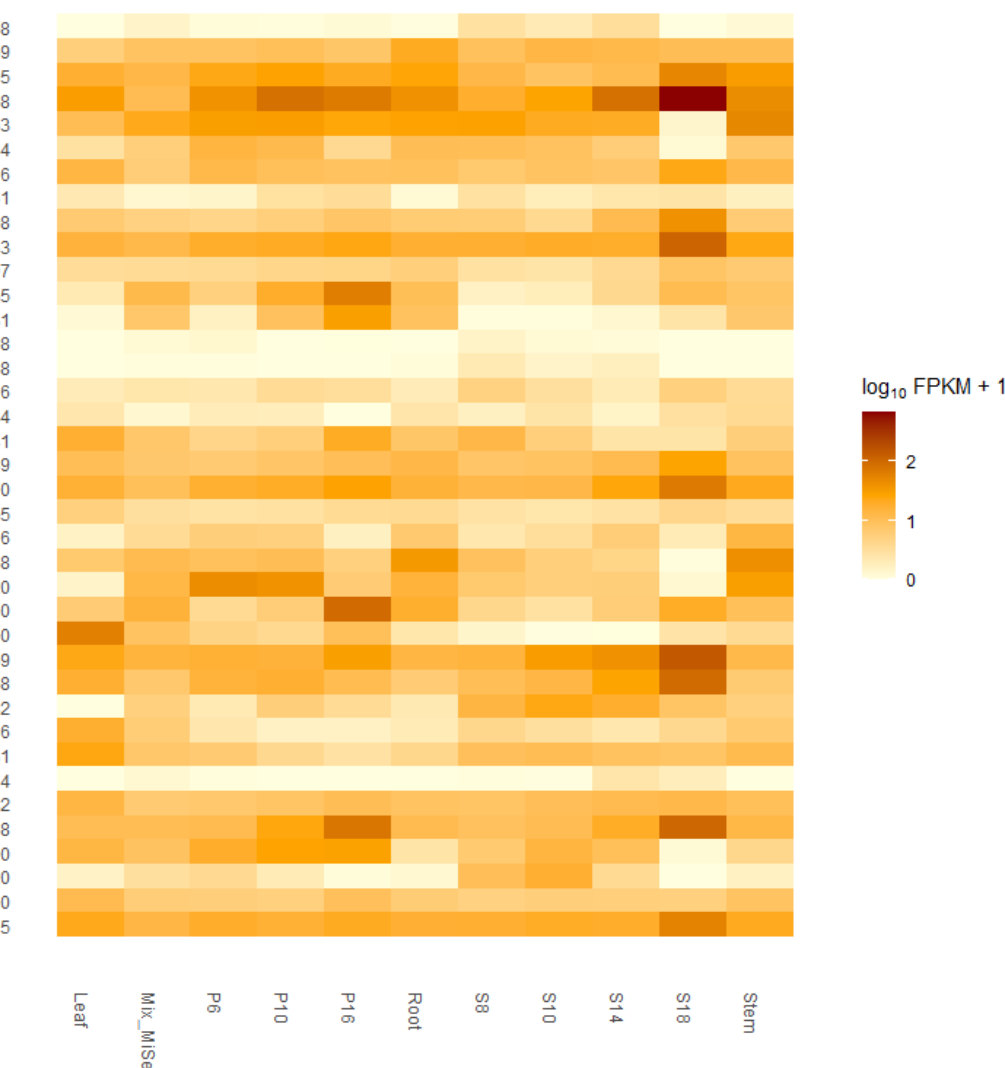
Figure 7. Expression of cowpea trihelix genes of major plant tissues at different developmental stages. (S8: Seed 8 days after pollination, S10: Seed 10 days after pollination, S14: Seed 14 days after pollination, S18: Seed 18 days after pollination, P6: Pod 6 days after pollination, P10: Pod 10 days after pollination, P16: Pod 16 days after pollination, Mix_MiSeq: Mix tissues). Heatmap was generated using cummerbund R package based on the FPKM (Fragments per kilobase of transcript per million mapped reads) value. Expression levels are depicted by same color with varying gradient from dark to light on the scale. Expression high: Expression value > 2, Expression medium: Expression value > 1, Expression low: 0 < Expression value <